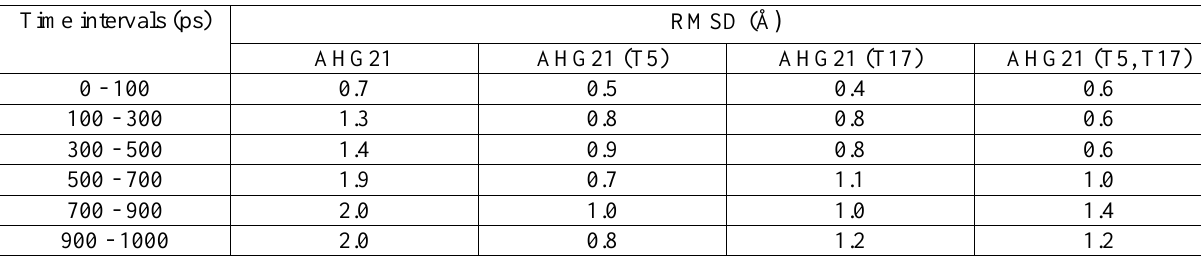
Table 2 . RMSD between coordinate sets of the backbone atoms (C α structures and corresponding average structures during the production run of MD